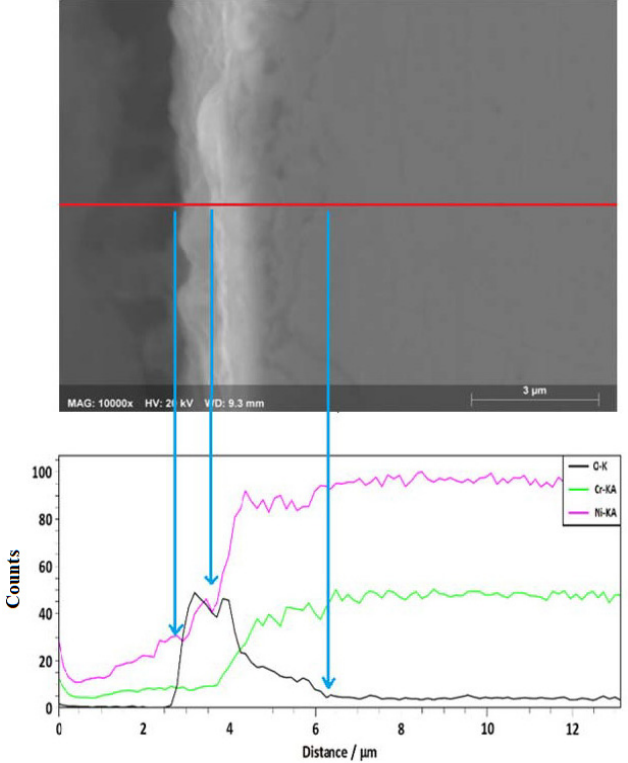
Figure 5. EDS line-scan of Ni20Cr alloy immersed in Solar Salt 500 °C for 1000 h.